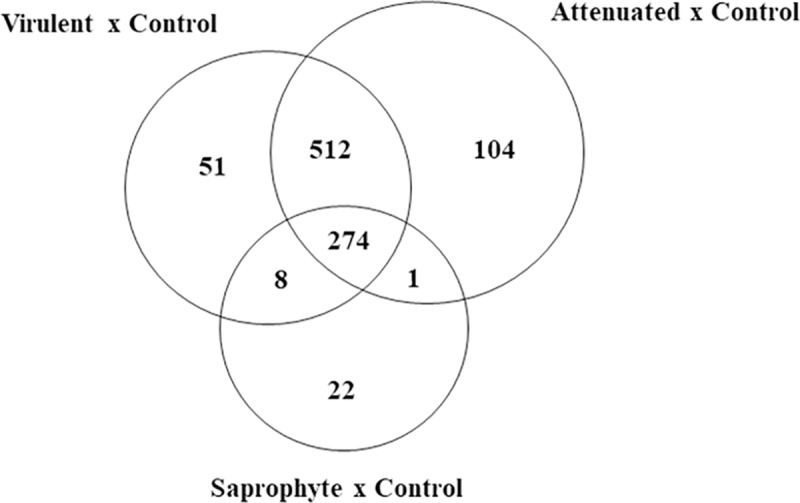
Venn diagram for differentially expressed genes after 6 hours of infection in murine macrophages J774A.1 with saprophytic, attenuated and virulent strains of Leptospira spp.Total number of canonical pathways (n = 3/treatment; FDR<0.05, fold change ± 2) in the contrasts Infected (Saprophyte; Attenuated and Virulent) vs. Non-infected Control.